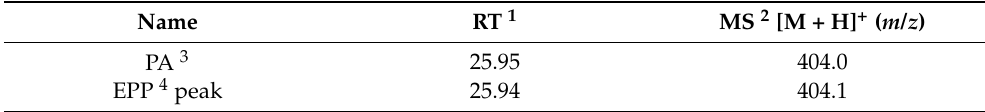
Table 1. The HPLC-MS data of PA and EPP